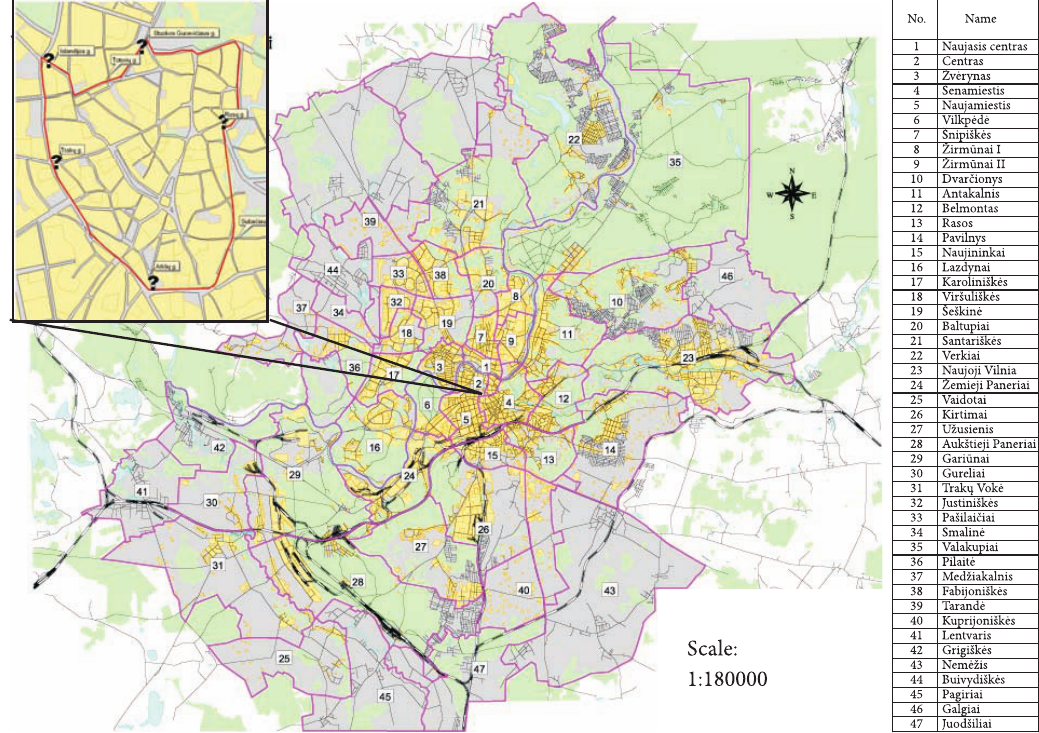
fig. 3. Transportation regions of Vilnius City and main entrances to Old Town (questioning sites marked by ?